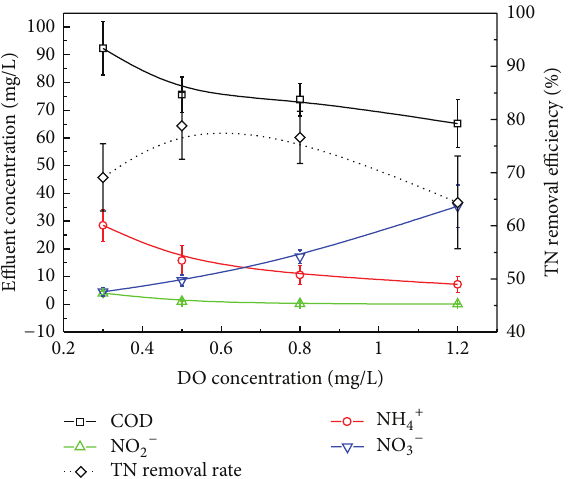
Figure 6: Reactor performance under different DO concentrations.